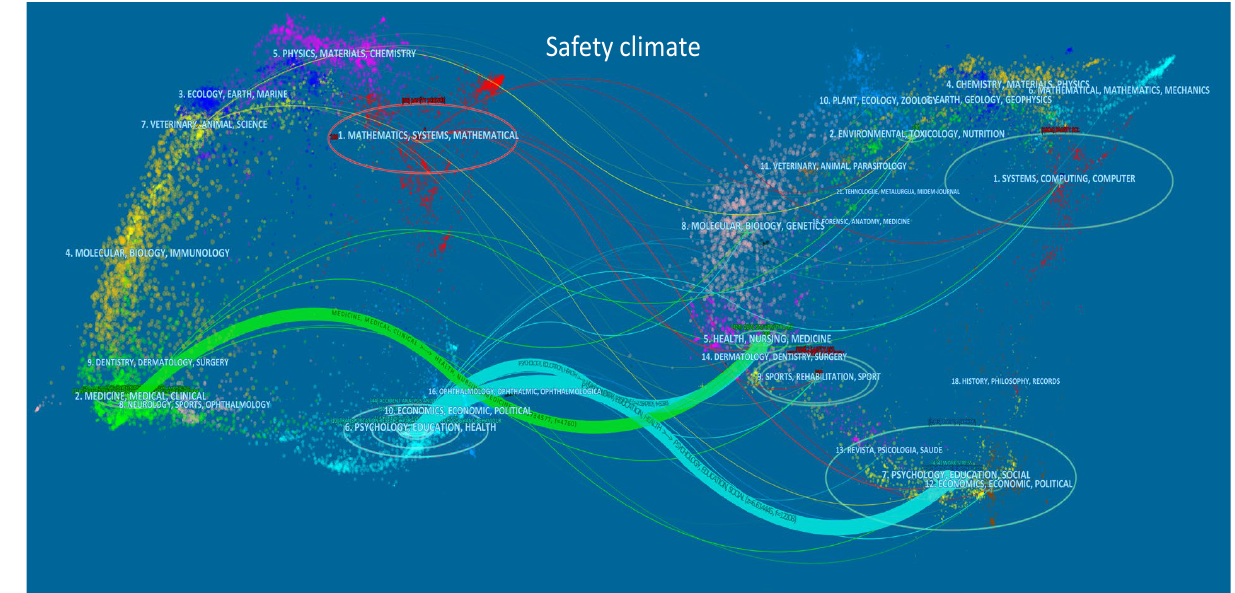
Figure 4. Dual map overlay of safety climate publications (generated using CiteSpace, see Section 2.2 for references). Note: The left-side clusters represent citing domains while the right-side clusters are cited domains; 154 citing journals and 4920 cited journals were mapped.